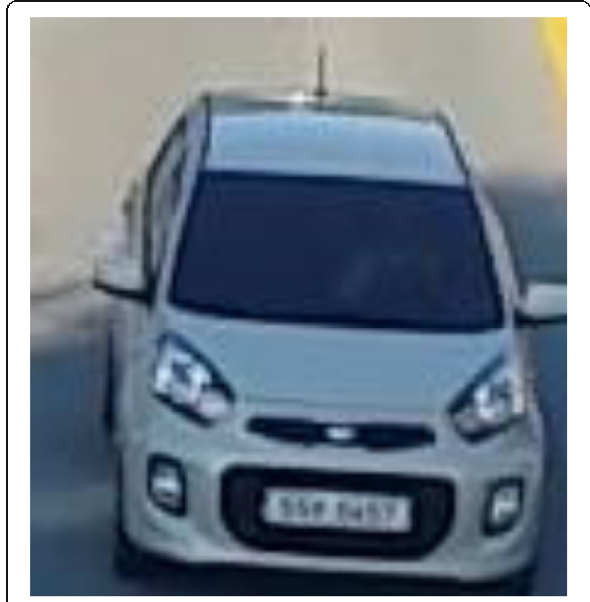
Fig. 3 Moving vehicle detected from the obtained images